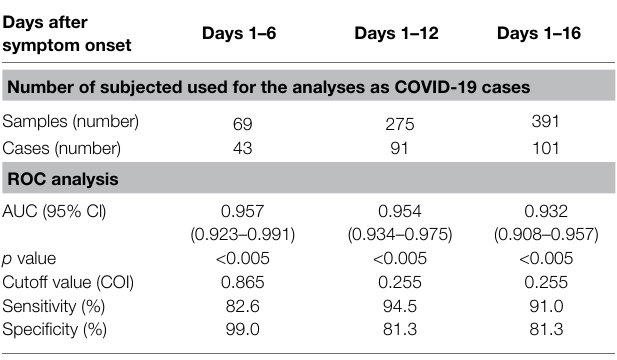
TABLE 1 | The time courses of the diagnostic values determined by ROC